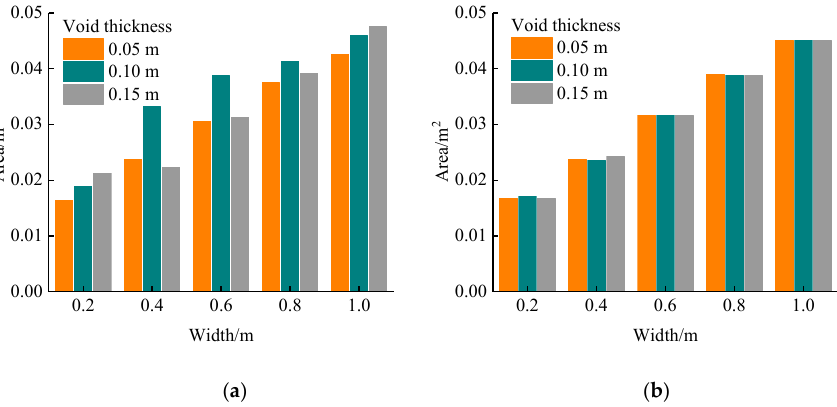
Figure 14. Void response area: ( a ) Interface I, ( b ) Interface Ⅱ . This figure shows the effect of width and thickness on the void response area. The area of the void response increased significantly with an increase in the void width, but the effect of the void thickness on the response area was not regular.